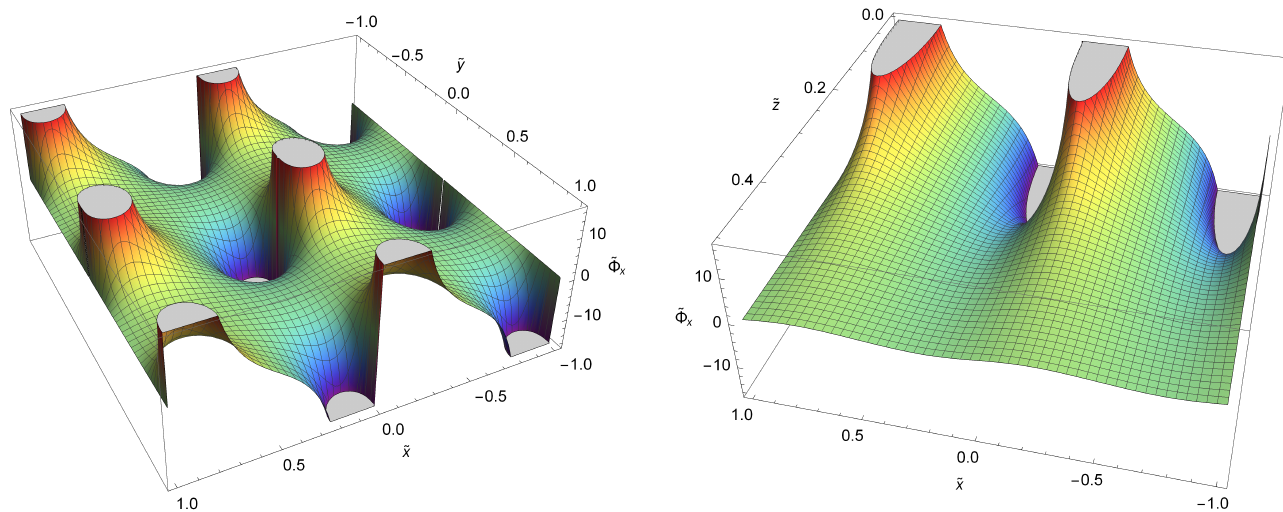
Figure 7. x -component of the rescaled force ˜ Φ x for ˜ λ eff = 1 for the sections z = 0 (left panel) and y = 0 (right panel).